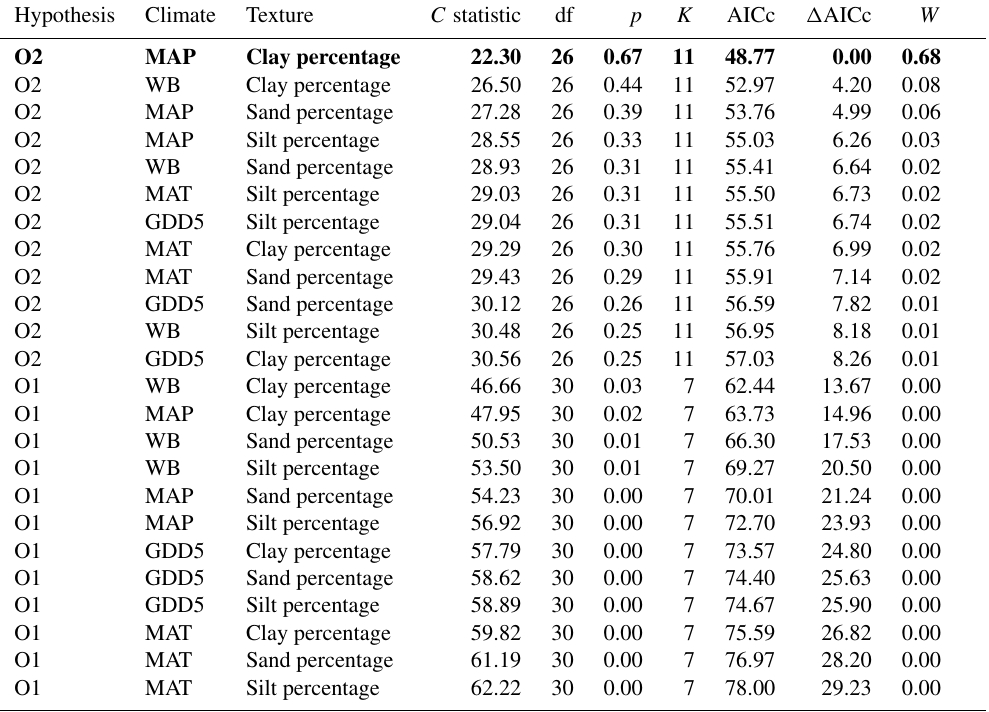
Table 3. Model fitness to the data for a priori hypotheses for the O layer. Models are sorted by the increasing second-order Akaike information criterion (AICc).